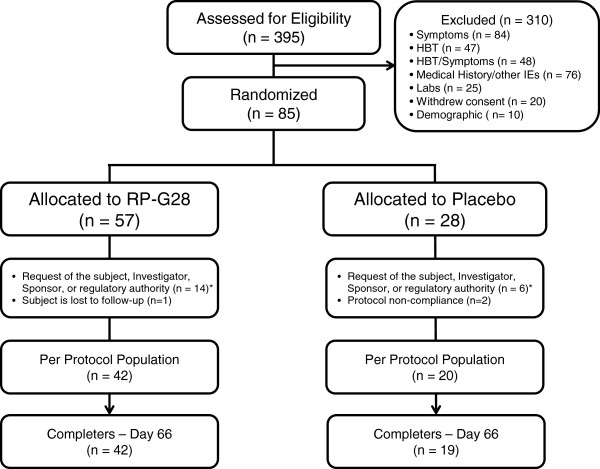
Subject disposition.